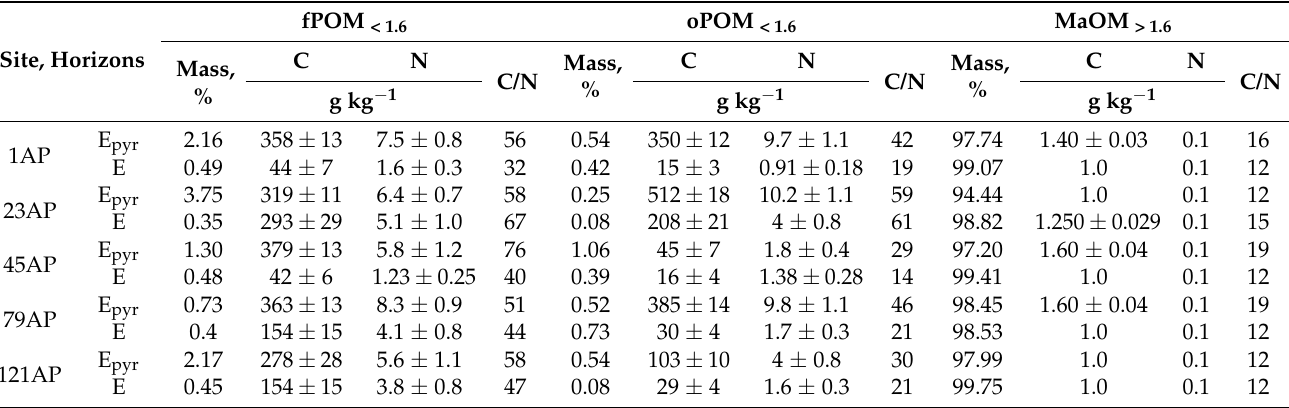
Table 3. Contribution of the fraction; carbon and nitrogen content in densimetric fractions of E pyr and E